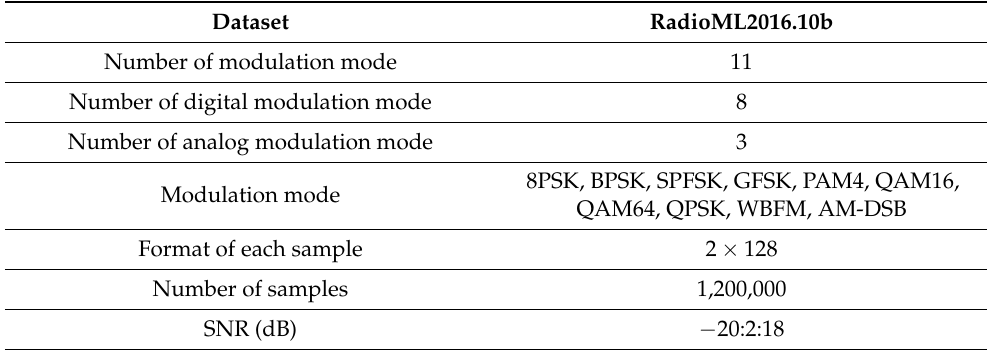
Table 8. Description of display parameters for Radio2016.10b